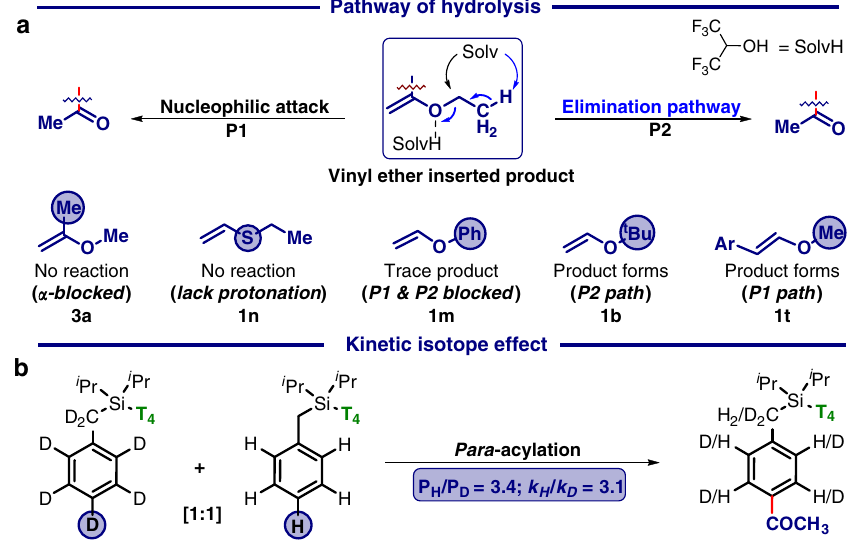
Fig. 4 Understanding the mechanistic features. a Plausible pathways of hydrolysis. b Determination of kinetic isotope effect